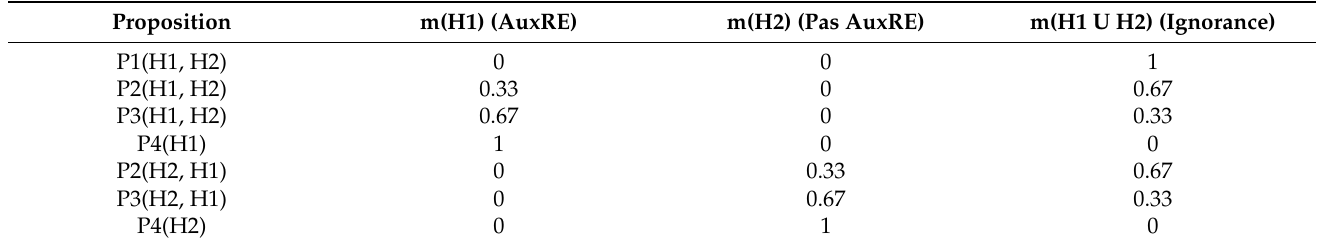
Table 1. Seven possibilities for the various preference degrees expressing the hesitation between the two hypotheses, H1 and